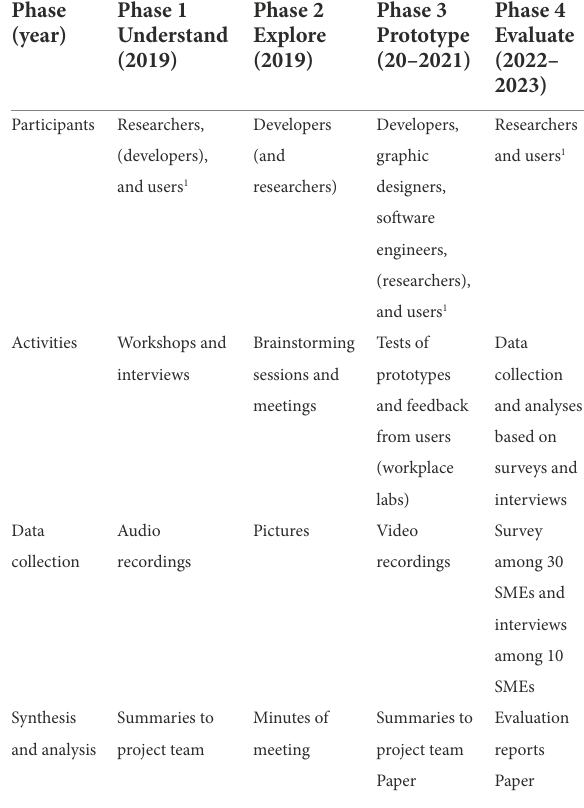
TABLE 1 Overview of team activities during team meetings. TABLE 2 Overview of the design